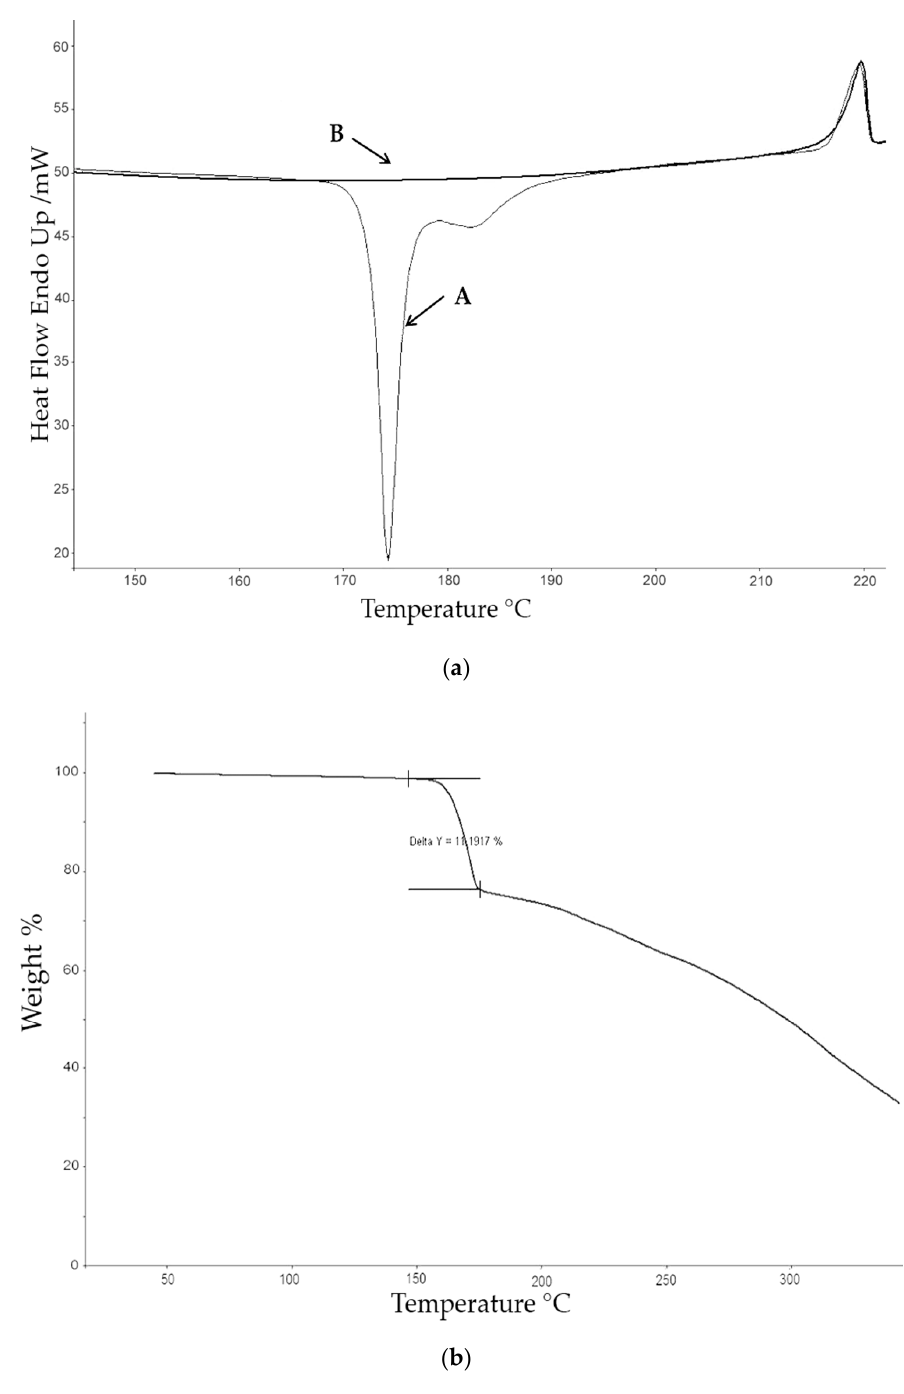
Figure 7. DSC ( a ) and TG ( b ) of compound VA7J. ( a ) Curve A: first scan (desolvation) and curve B: second scan; ( b ) TG of compound VA7J at 10 °C/min.